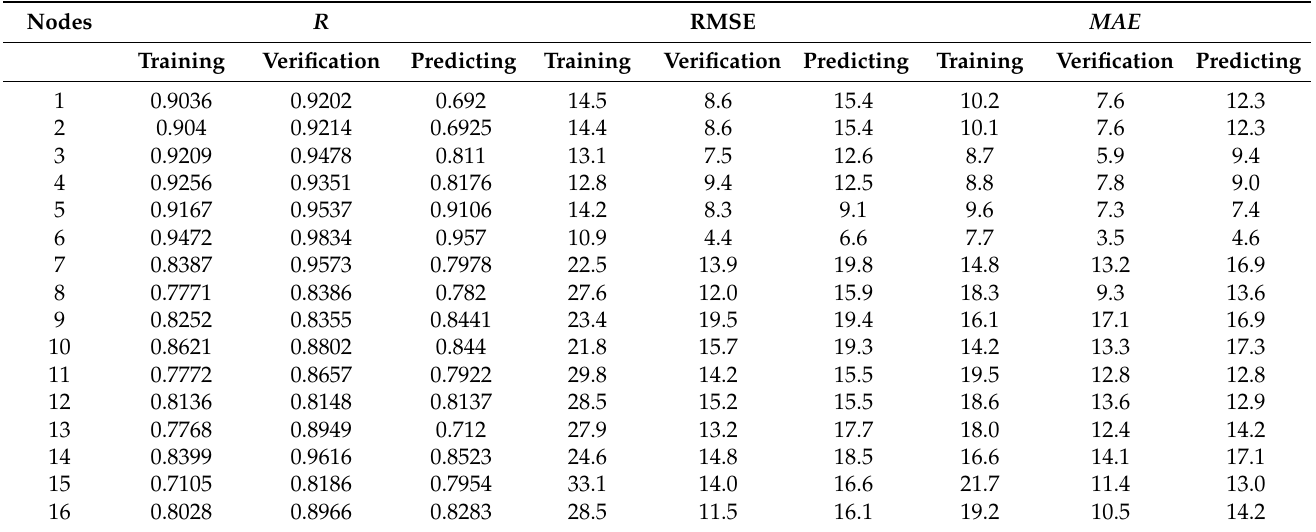
Table 4. Comparison of R , RMSE ( µ g/m 3 ), and MAE ( µ g/m 3 ) between different nodes in the hidden